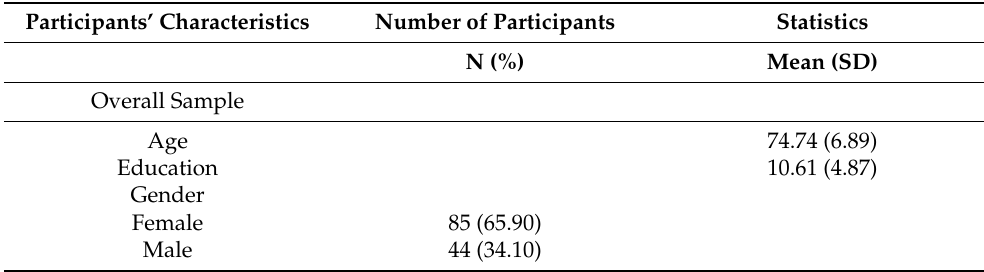
Table 1. Sociodemographic characteristics of participants (N = 129).